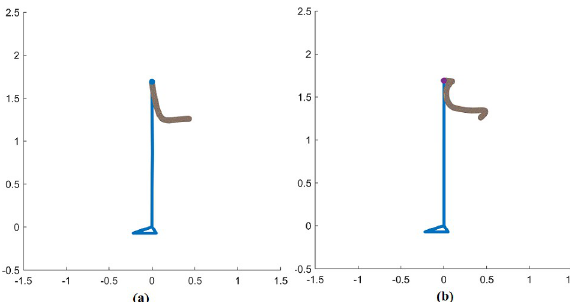
Fig 10. Head potion trajectory a) Reference head trajectory b) Head trajectory motion with